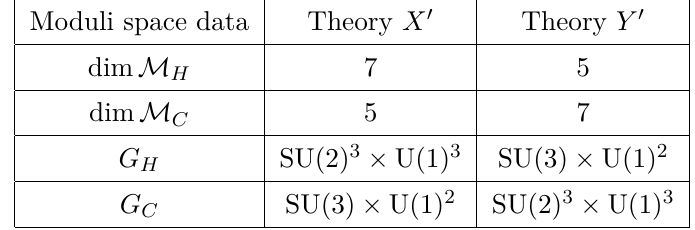
Table 3 . Summary table for the moduli space dimensions and global symmetries for the mirror pair in figure